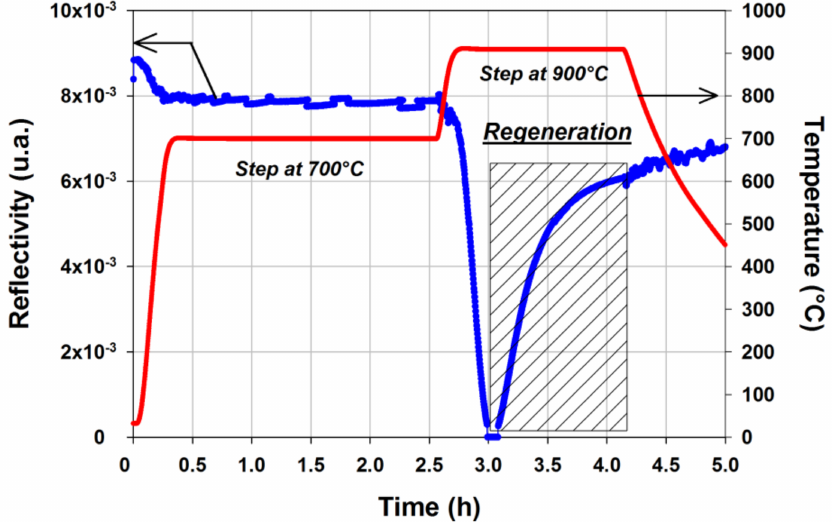
Figure 5. Evolution of the FBG reflectivity versus time during the regeneration process of a seed FBG photowritten into a SMF-28 optical fiber H 2 -loaded during two weeks at room temperature prior to the grating’s inscription with a cw frequency-doubled argon ion laser emitting 100 mW at 244 nm (experiment performed at CEA